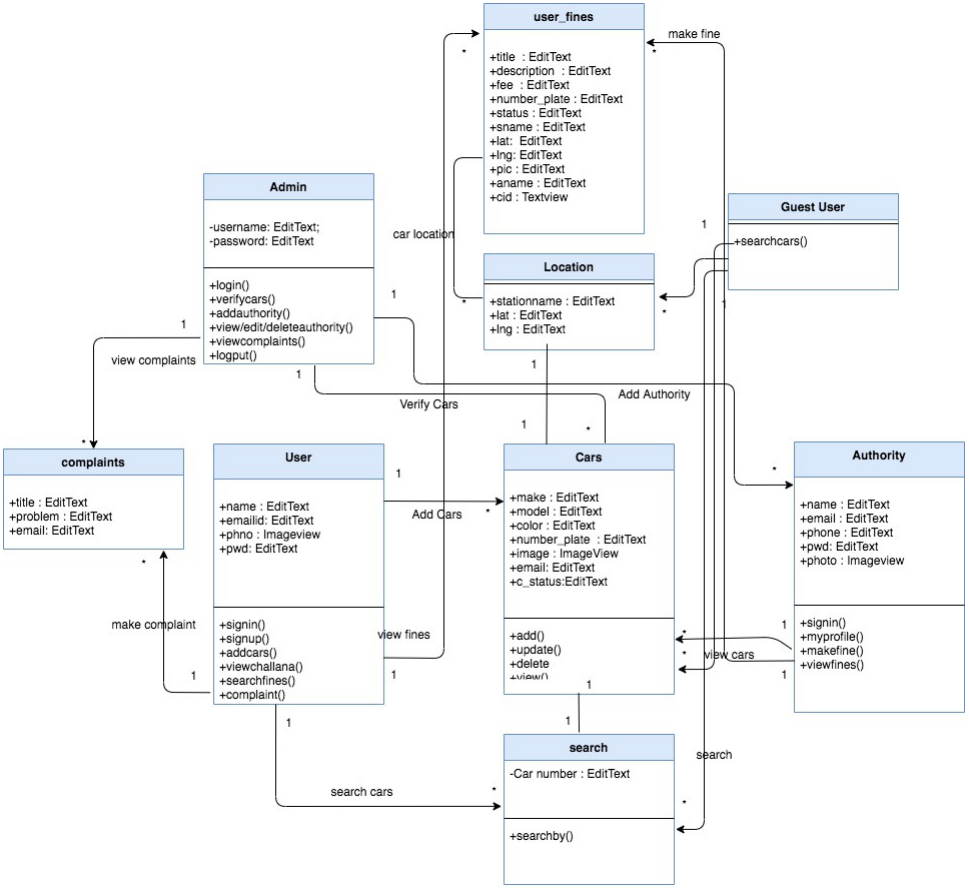
Figure 4. Class diagram of the car towing management system.